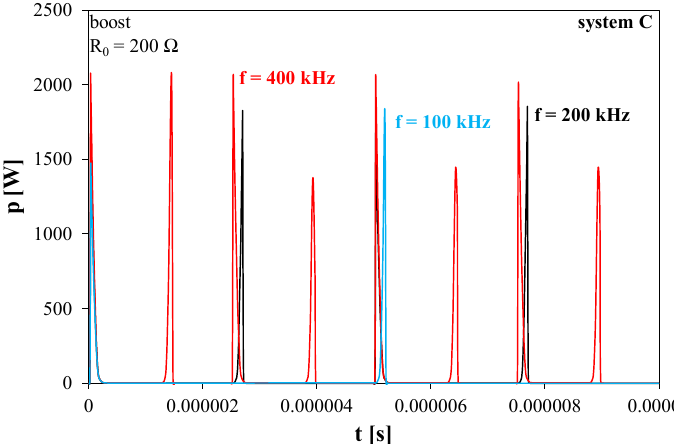
Figure 13. Waveforms of the power dissipated at the steady state in the transistor operating in the boost converter and cooperating with system C at selected frequency values.